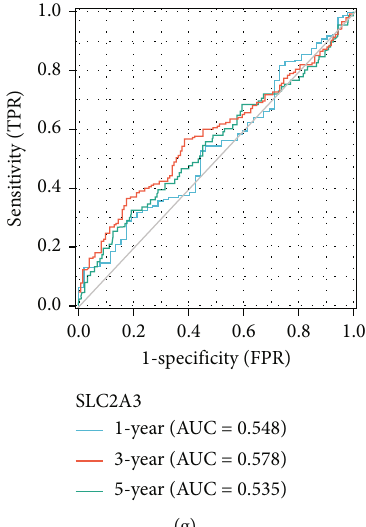
Figure 4: E ff ect of SLC2A3 on HNSCC prognosis. ROC curve showed promising predictive power (a). High expression of SLC2A3 related to poor OS and DSS, respectively, analyzed using R software (b, c). High expression of SLC2A3 related to RFS, analyzed using Kaplan-Meier Plotter database (d). A nomogram for predicting 1-, 3-, and 5-year survival probability (e). ROC curve for 1-, 3-, and 5-year OS showed the AUG values of 0.548, 0.578, and 0.535, respectively (f). Calibration plot of the nomogram-predicted survival